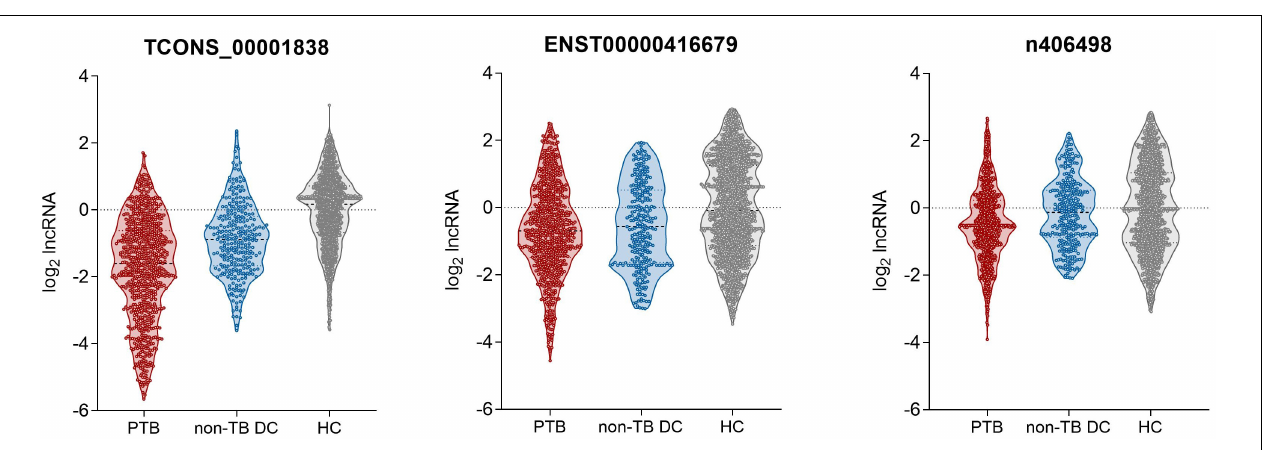
FIGURE 2 | Bioinformatics analysis of candidate lncRNAs.